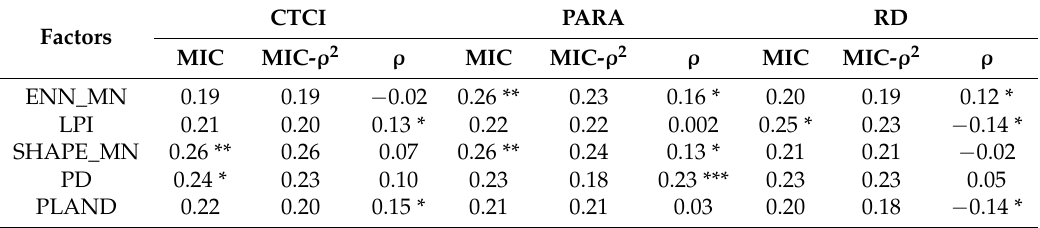
Table 2. Associations between landscape metrics and the urban form